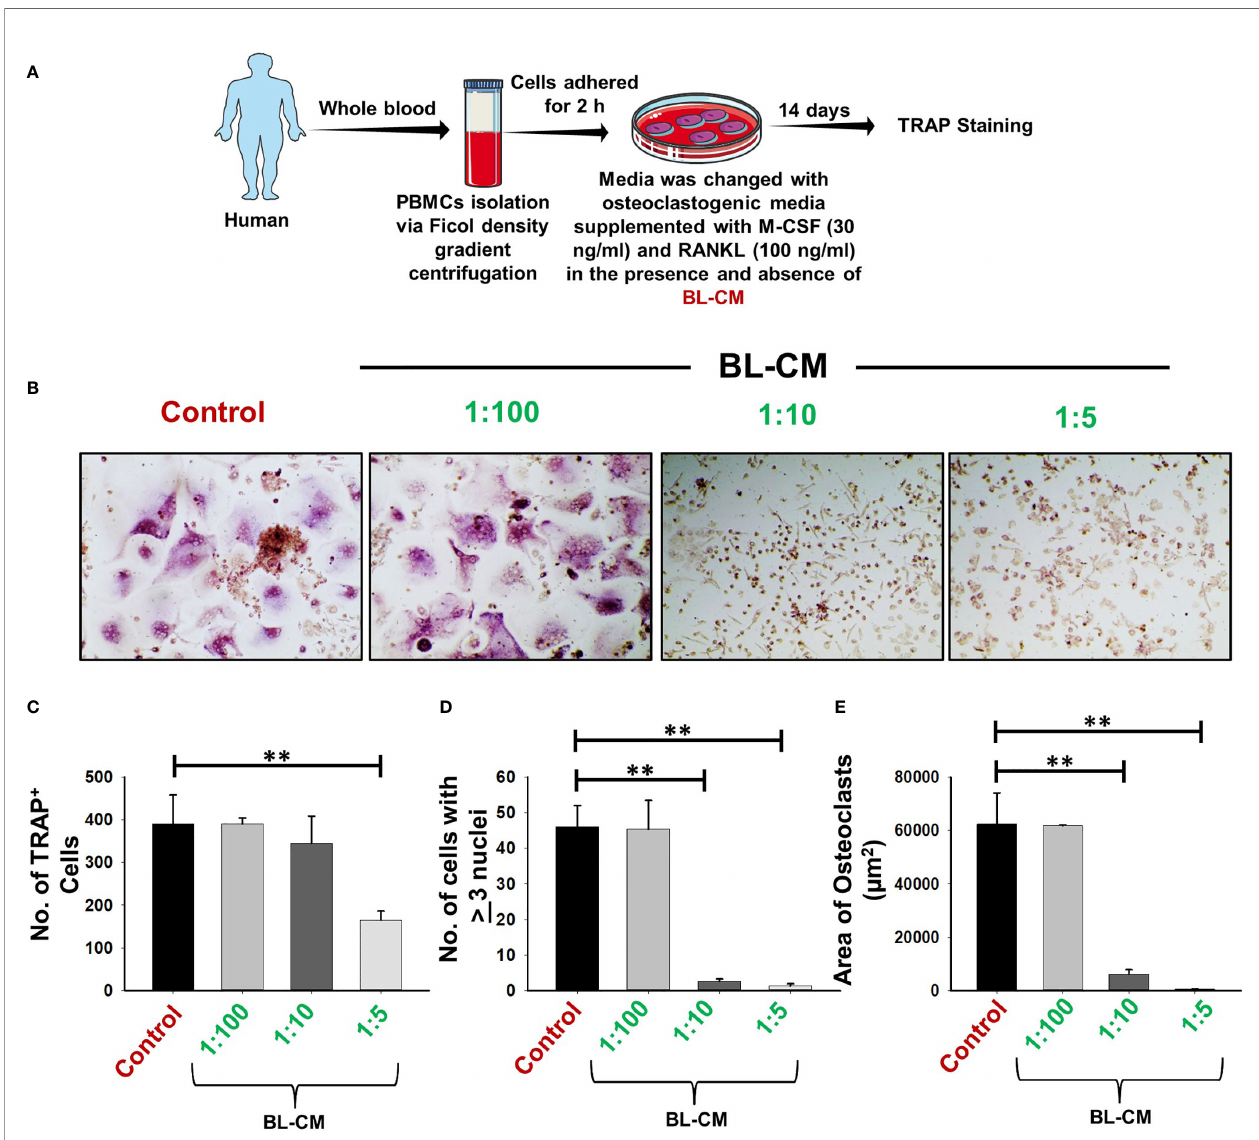
FIGURE 11 | BL-CM suppress osteoclastogenesisin human PBMCs: (A) Osteoclastdifferentiation was induced inhuman PBMCs with M-CSF (30 ng/ml) and RANKL (50 ng/ml) with or without Bi fi dobacterium longum -conditioned media (BL-CM) at different ratios of1:100, 1:10, and 1:5 for 14 days. Giant multinucleated cells were stained with TRAP, andcells with ≥ 3 nuclei wereconsidered as mature osteoclasts. (B) Photomicrographs at ×20 magni fi cationswere taken. (C) Number of TRAP-positive cells. (D) Number ofTRAP-positive cells with more than 3 nuclei. (E) Area of osteoclasts. The above images are indicative of one independentexperiment, andsimilar results were obtainedin at least three differentindependent experiments. Statistical signi fi cance was considered as p ≤ 0.05 (**p ≤ 0.01) with respect to indicated